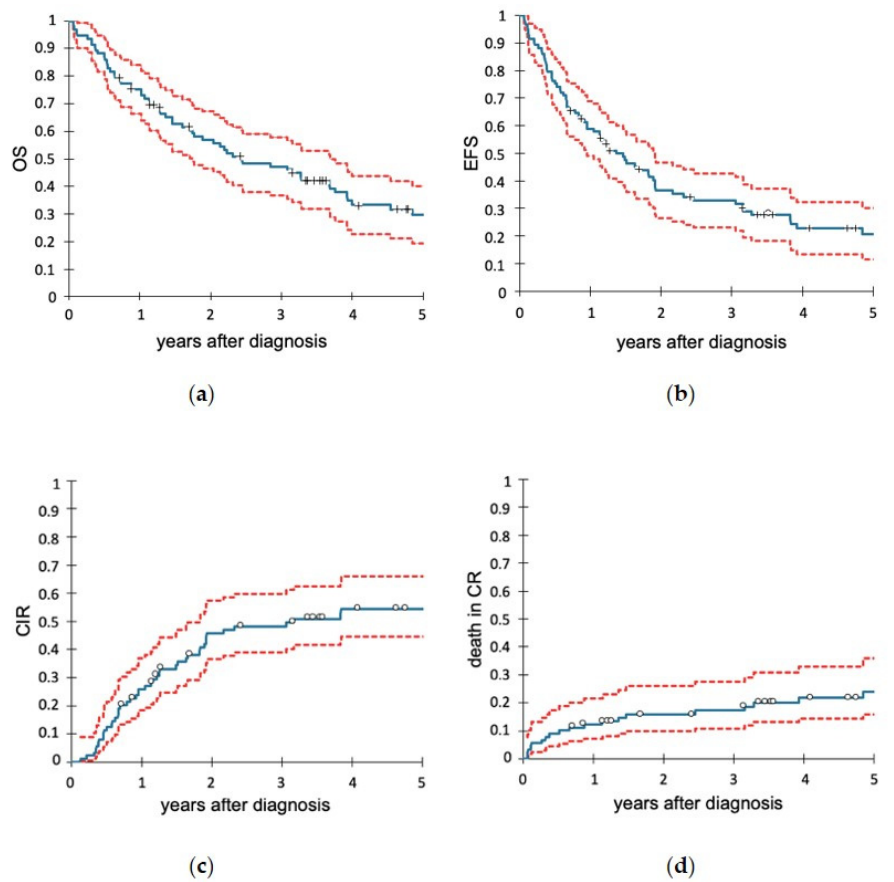
Figure 2. Outcomes of all intensively treated patients with B-precursor or T-ALL ( n = 93). ( a ) Overall survival (OS). ( b ) Relapse-free survival (RFS). ( c ) Cumulative incidence of relapse (CIR). ( d ) Death in complete remission (NRM). In the diagrams, the blue lines show the Kaplan-Meier curves, and the red lines indicate the respective 95% confidence intervals.